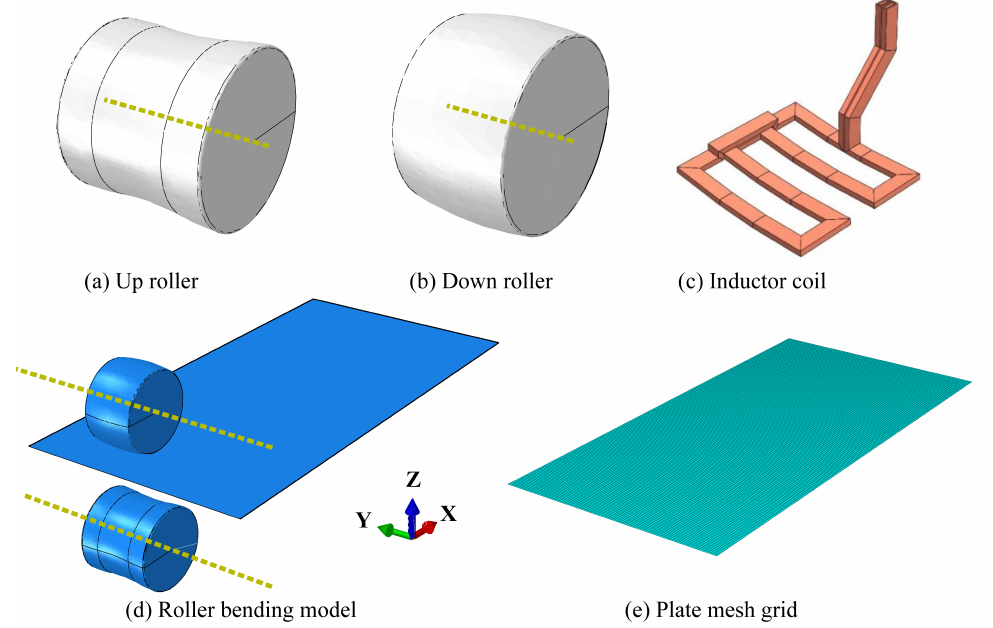
Figure 17. Finite element model ( a ) up roller, ( b ) down roller, ( c ) inductor coil, ( d ) roller-bending model, ( e ) plate mesh